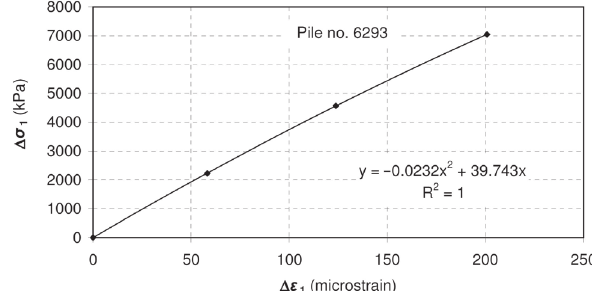
Figure 5: The stress–strain relation in the first measuring section of the pile shaft, determined for the unloading phase and described by function (for the same example as in Fig. 1, pile no.